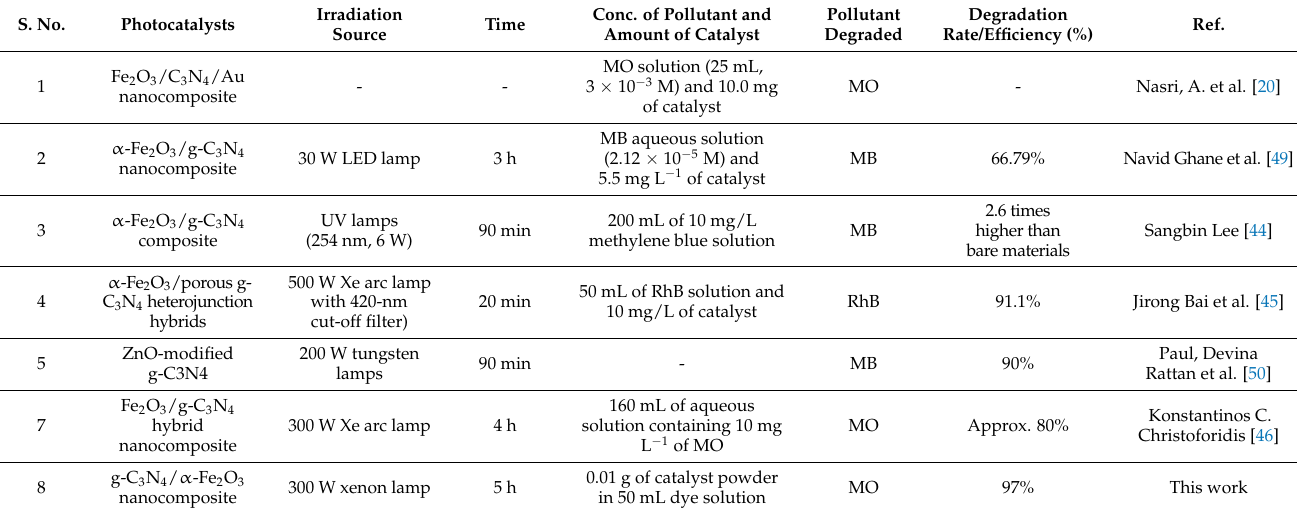
Figure 11. Chemical structure of MO dye. Table 2. Comparison with literature.